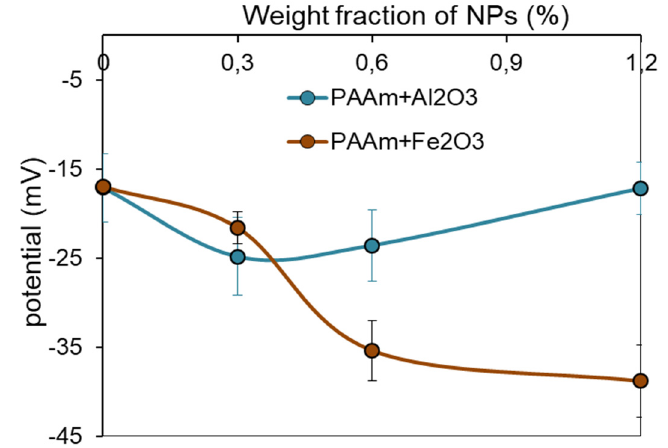
Figure 6. Dependence of electrical potential in gels on the concentration of Fe 2 O 3 or Al 2 O 3 nanoparticles. Data presented as mean value and SD bar ( n = 7).